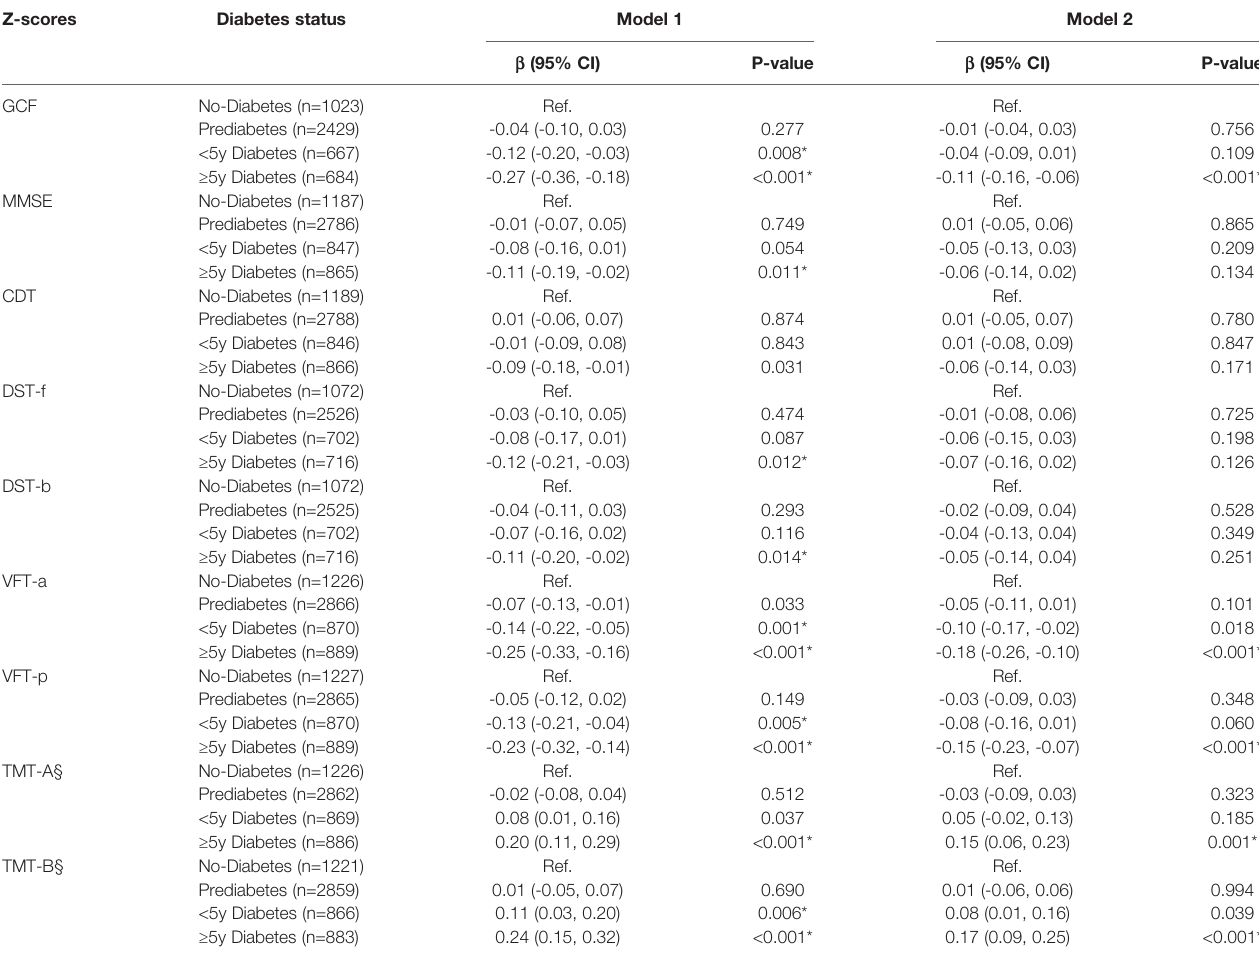
TABLE 2 | Association between baseline diabetes status and changes in cognitive